Question: Give a one-sentence summary of this figure.
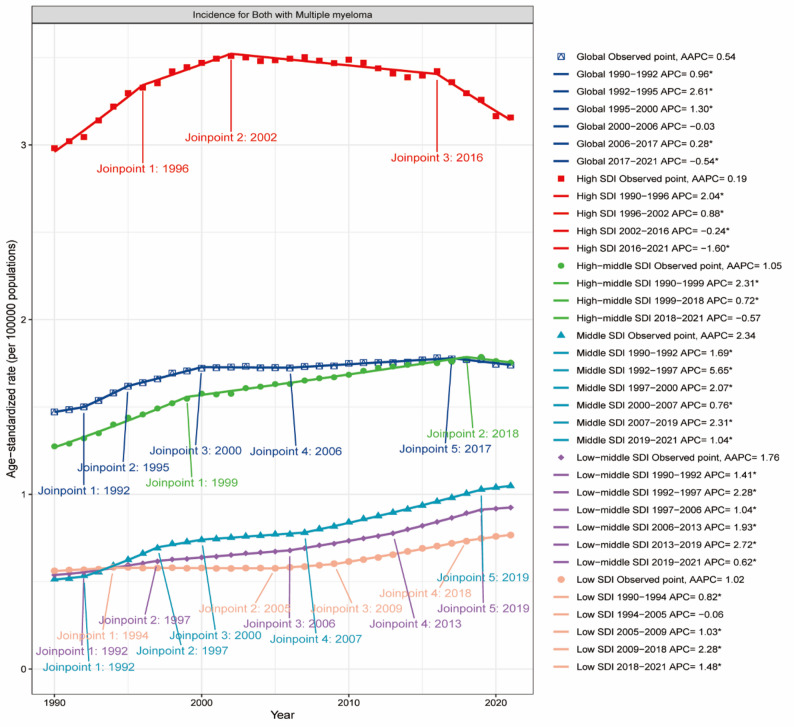
Answer: Temporal trends in ASIR for MM on a global scale and within diverse SDI regions (1990–2021), analyzed using the Joinpoint regression model. * p < 0.05